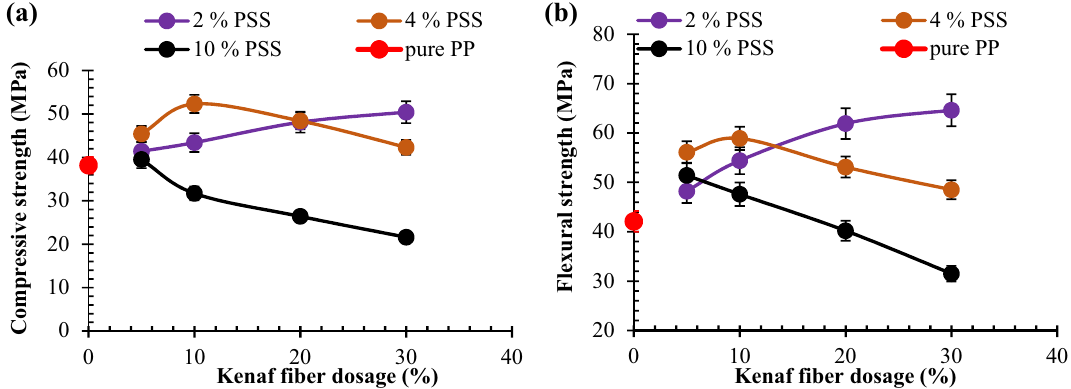
Figure 5. Graphical plot for the interaction between admix of kenaf fiber (KF)/particulate snail shell (PSS) at varying proportion and ( a ) compressive strength ( b ) flexural